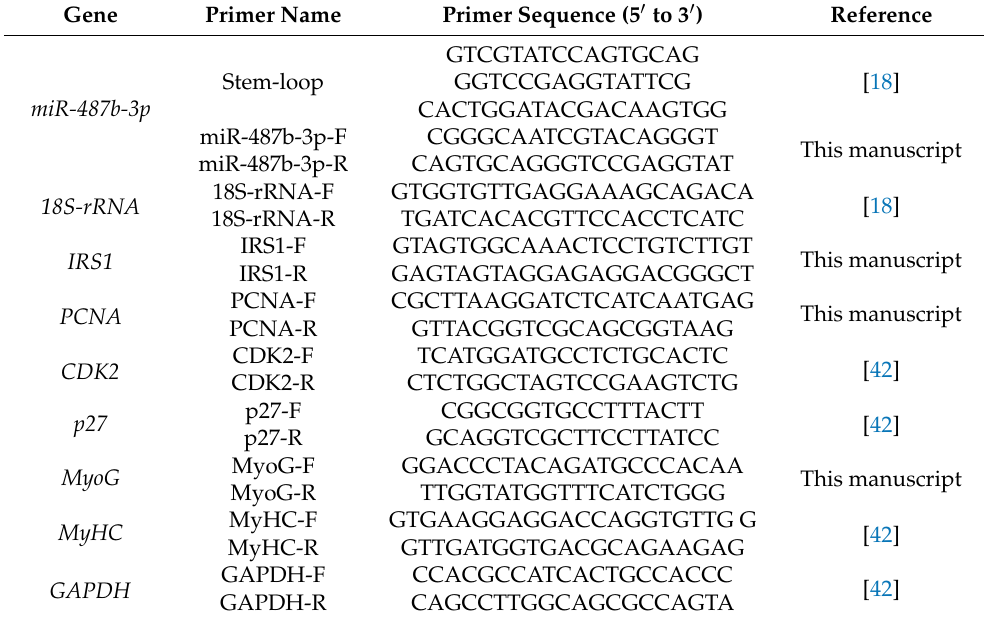
Table 1. Primer information for miRNA and mRNA quantitative reverse transcription. Gene Primer Name Primer Sequence (5 (cid:48) to 3 (cid:48)